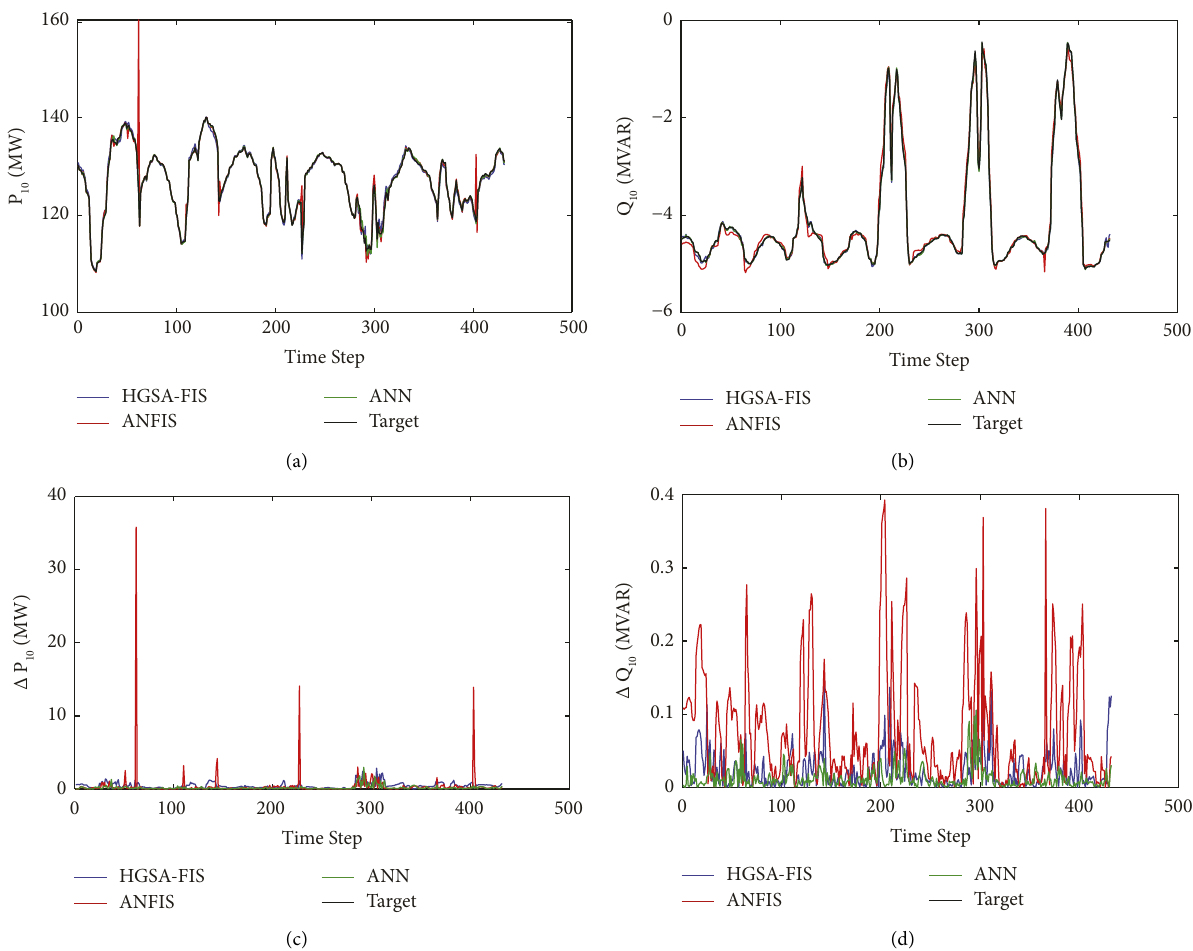
Figure 11: Comparison of prediction accuracy of HGSA-FIS, ANFIS, and ANN models in predicting tie-line L10 power flows: (a) P | , and (d) APE | Δ Q Q , (c) APE | Δ P 10 10